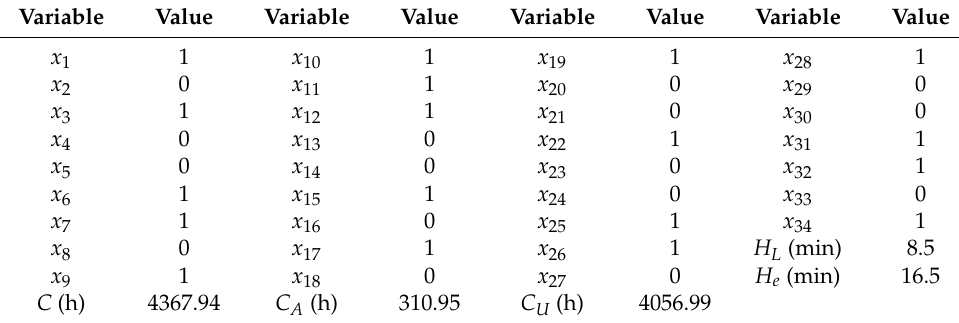
Table 3. The results of the case study in Jinan obtained by the genetic algorithm. Variable